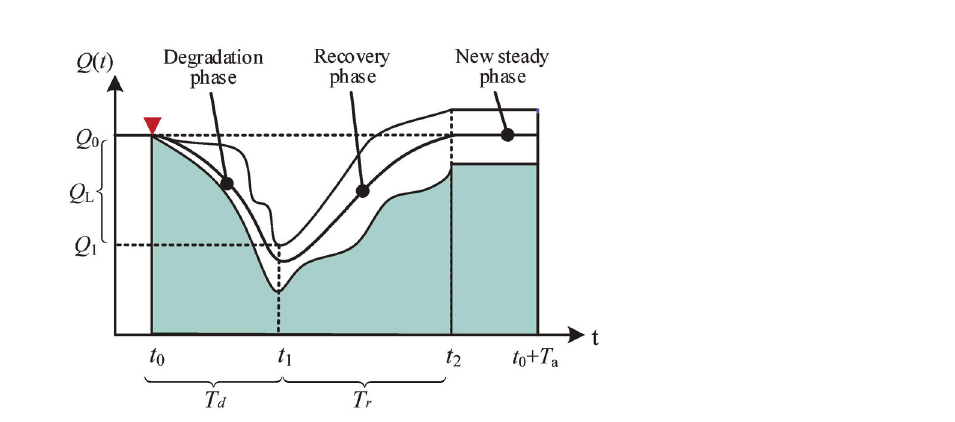
Fig 1. A typical performance process after a